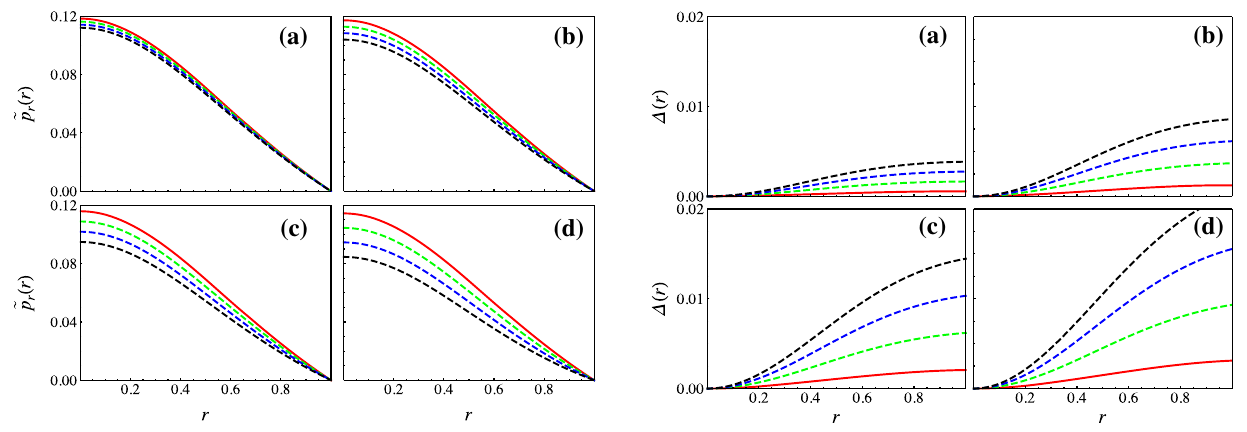
Fig. 2 Effective radial pressure ˜ p r for M = 0 . 2, R = 1, c 1 = 0 . 5 and a C = − 0 . 1, b C = − 0 . 2, c C = − 0 . 3, d C = − 0 . 4. α = 0 . 1 (red line), α = 0 . 3, (green line), α = 0 . 5 (blue line), α = 0 . 7 (black line)